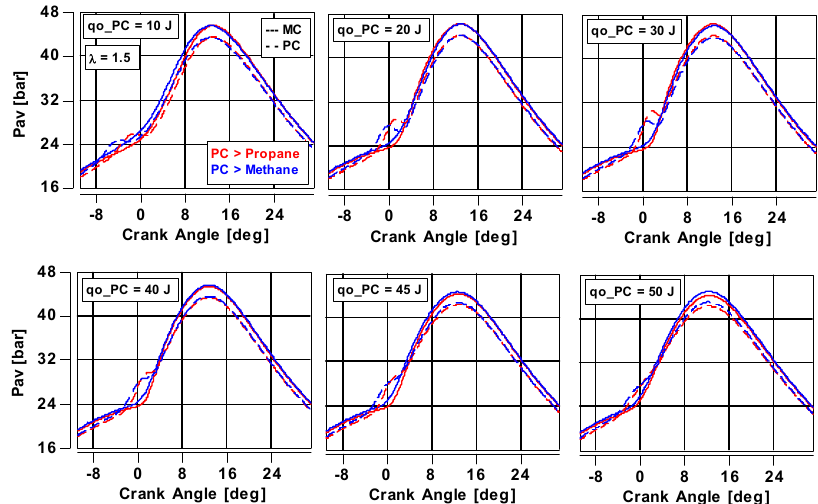
Figure 10. Conditions of pressure change in the cylinder during the combustion of propane (PC) and methane (MC), as well as combinations of methane (PC) and methane (MC) at different values of energy injected into the prechamber at λ = 1.5 (the most favorable combustion conditions regardless of the fuel initial dose).